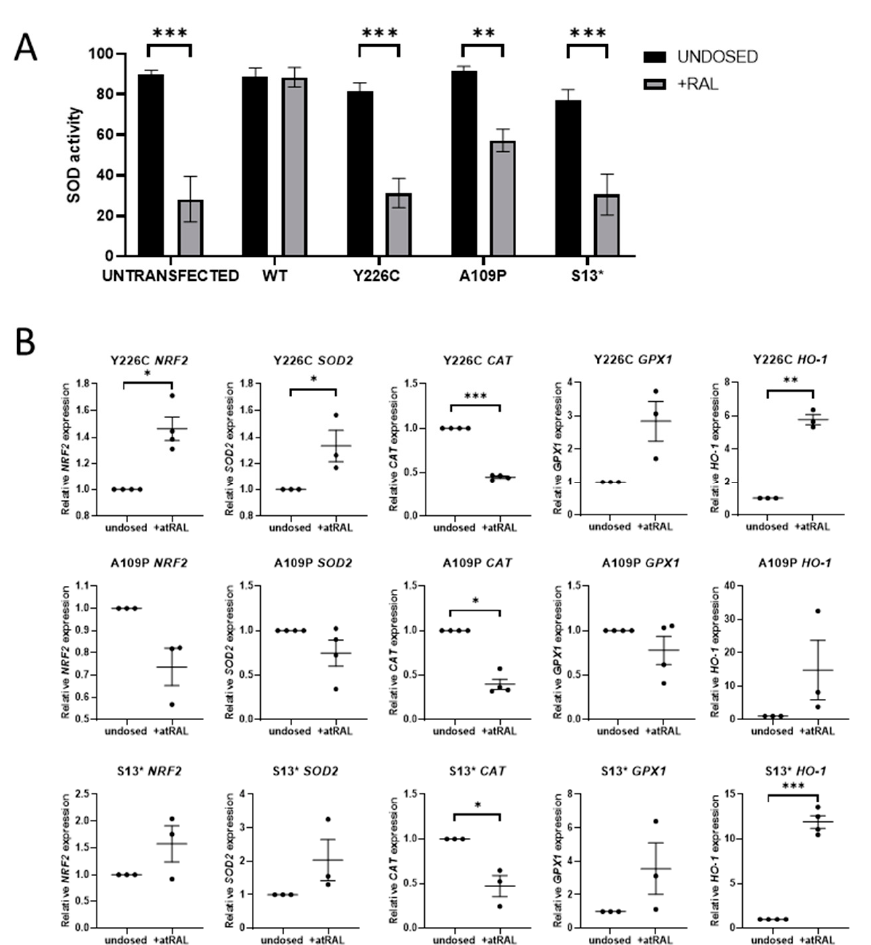
Figure 2. RDH12 protects cells from atRAL-induced oxidative stress. ( A ) Dosing untransfected cells with 50 µ M atRAL for 24 h causes a significant reduction in SOD activity, indicating an increase in oxidative stress. Cell expressing WT RDH12 are protected from atRAL-induced oxidative stress. Dosing with atRAL causes a significant reduction in SOD activity in mutant cells. Statistical significance was analysed using two-way ANOVA and Sidak’s multiple comparison test. ** p ≤ 0.01, *** p ≤ 0.001. ( B ) Expression of oxidative stress markers NRF2, SOD2, CAT, GPX1, and HO-1 was analysed by RT-qPCR following treatment with 50 µ M atRAL for 24 h. Statistical significance was analysed with paired t -test. * p ≤ 0.05, ** p ≤ 0.01, *** p ≤ 0.001.